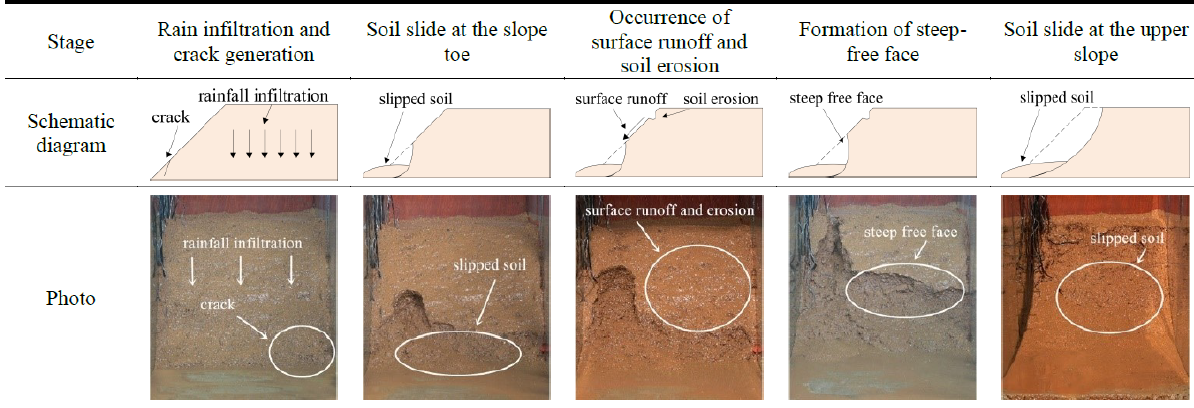
Table 2. Schematic diagrams and photos of the landslide formation.